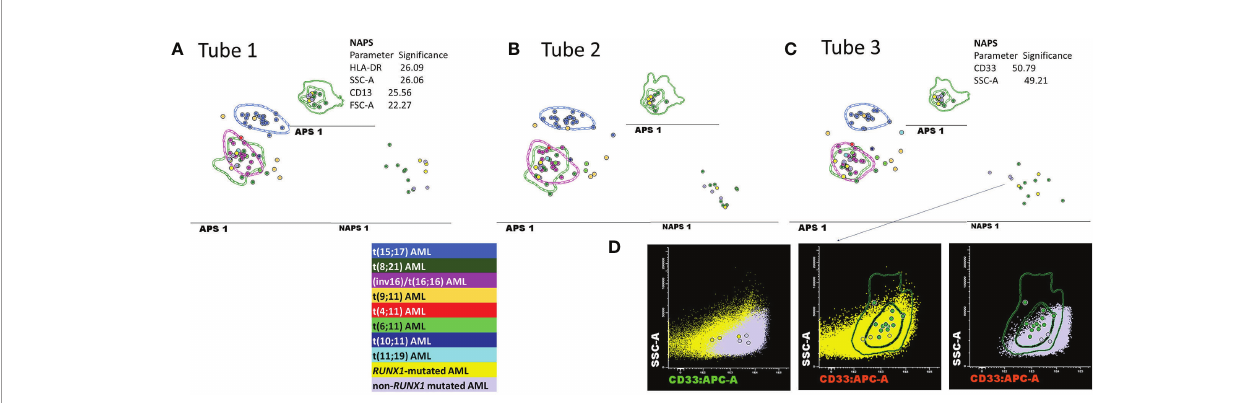
FIGURE 6 | Detailed evaluation of the false-positive t (8;21) AML cases. (A – C) APS plots showing the perfect overlap between the medians for the blast events from the false-positive t (8;21) AML cases (bright yellow and mauve circles) with those for the t (8;21) AML group (green circles, the dotted line represents the 1 standard deviation (SD) curve for the group) and for the inv(16)/ t (16;16) AML group (violet circles, the dotted line represents the 1 SD curve of the group) using the fi rst three tubes of the EF AML/MDS panel. In the tube 3 of EF AML/MDS panel, the neighborhood automatic population separator (NAPS) diagrams allow for the division of false-positive t (8;21) AML cases into two groups, according to the presence (bright yellow circles) or absence (mauve circles) of RUNX1 mutation according to NGS analysis. The tables show the contributions of each parameter to the separation of the false-positive t (8;21) AML blasts from the t (8;21) AML group in the NAPS diagrams, re fl ected as percentages. (D) Bivariate dot plots illustrating the differences in the CD33 and SSC parameters between RUNX1 -mutated cases (yellow dots and circles representing the median CD33 expression for an individual case) and RUNX1 nonmutated cases (mauve dots and circles representing the median CD33 expression for an individual case) compared with t (8;21) AML cases (green circles representing the median CD33 expression for an individual case; the dotted line represents the 1 SD curve, and the solid line represents the 2 SD curve for the AML